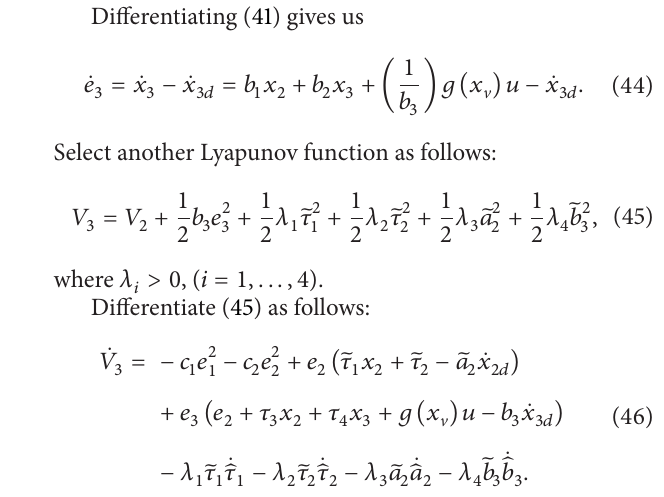
Figure 7: The response of adaptive backstepping controller.